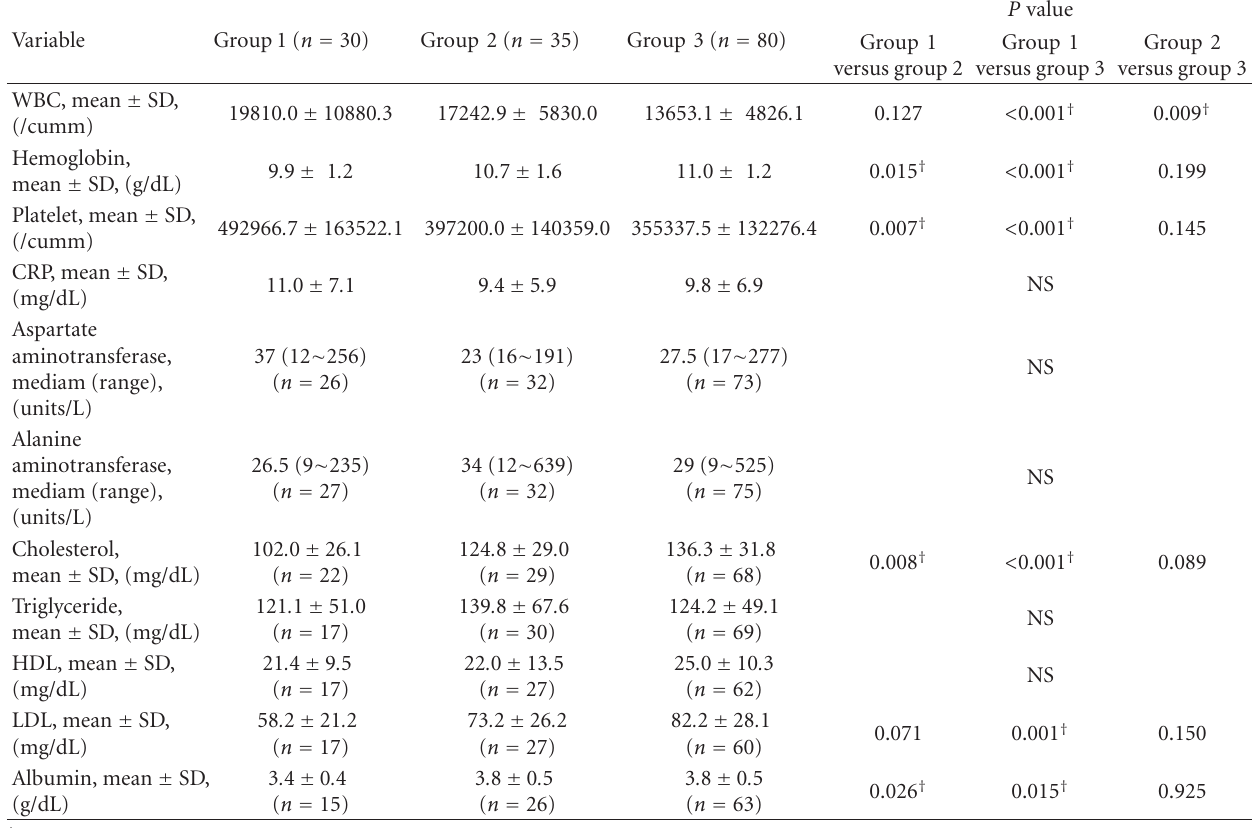
Table 2: Laboratory results.